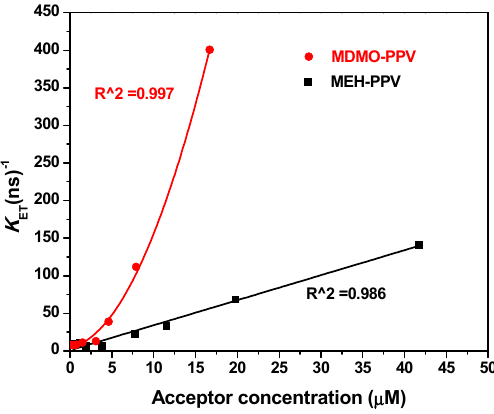
Figure 12. Energy-transfer rate ( k ET ) versus various weight ratios of MEH-PPV (black color) and MDMO-PPV–DMP (red color). Solid curves refer to the fitting data.